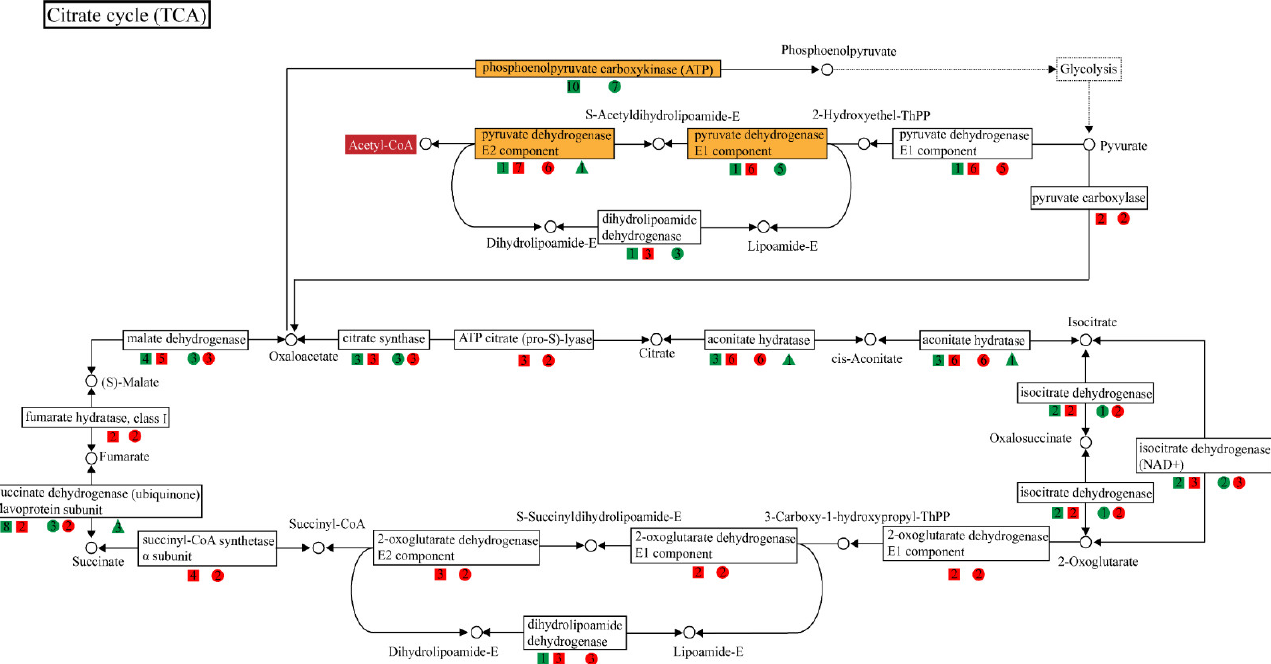
Figure A1. DEGs in the TCA cycle. Squares represent DEGs based on the comparison between gall vs. LWG; circles represent DEGs based on the comparison between gall vs. LNG; triangles represent DEGs based on the comparison between LNG vs. LWG. Red color indicates up-regulation and green color indicates down-regulation. The numbers within shaded shapes indicate the number of genes. There were 52 genes up-regulated and 34 genes down-regulated based on the comparison between gall vs. LWG, 44 genes up-regulated and 19 genes down-regulated based on the comparison between gall vs. LNG, and 5 genes down-regulated based on the comparison between LNG vs. LWG. The gene encoding aconitate hydratase was strongly up-regulated, but the gene encoding succinate dehydrogenase (ubiquinone) flavoprotein subunit was down-regulated in galls.